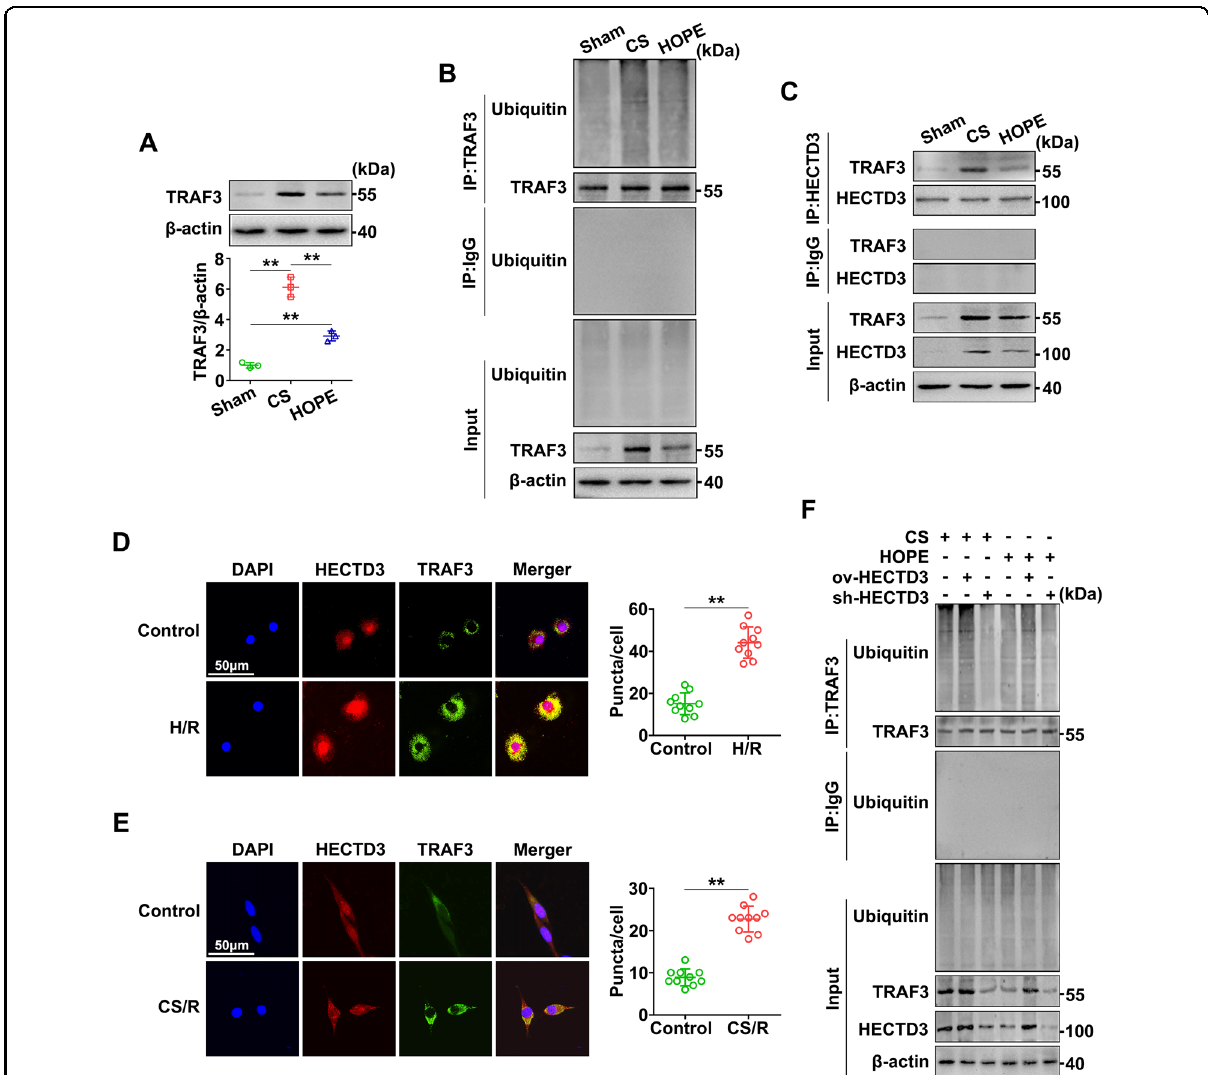
Fig. 5 HOPE inhibits the ubiquitination of TRAF3 by targeting HECTD3. A TRAF3 protein expression in liver was evaluated using western blot and quanti fi ed using a Gel-Pro Analyzer. Data are mean ± SD, ** P < 0.01 by one-way ANOVA followed by Tukey ’ s test. n = 3 per group. B , C Ubiquitination analysis of TRAF3 and Co-IP analysis of the interaction between HECTD3 and TRAF3. Liver tissues protein extracts were IP with primary antibody for TRAF3 ( B ) or HECTD3 ( C ). The immunoprecipitates were blotted with the relative antibodies. D , E Co-localization of HECTD3 and TRAF3 in hepatocyte and LSECs. IF staining of HECTD3 and TRAF3 were examined in BRL-3A cells with or without H/R and examined in LSECs with or without CS/R. DAPI was used to counter stain nuclei. The stained fl uorescence was observed using a fl uorescence microscope and quanti fi ed using Image-pro plus 6.0. Scale bar = 50 μ m. Data are mean ± SD, ** P < 0.01 by Student ’ s two-tailed unpaired t -test. n = 10 per group. F Ubiquitination analysis for the regulation of endogenous TRAF3 by HECTD3. Partial groups of rats were infected with ov-HECTD3 or sh-HECTD3 AAV8. Liver tissues protein extracts were immunoprecipitated with primary antibody for TRAF3. The immunoprecipitates were blotted with the relative